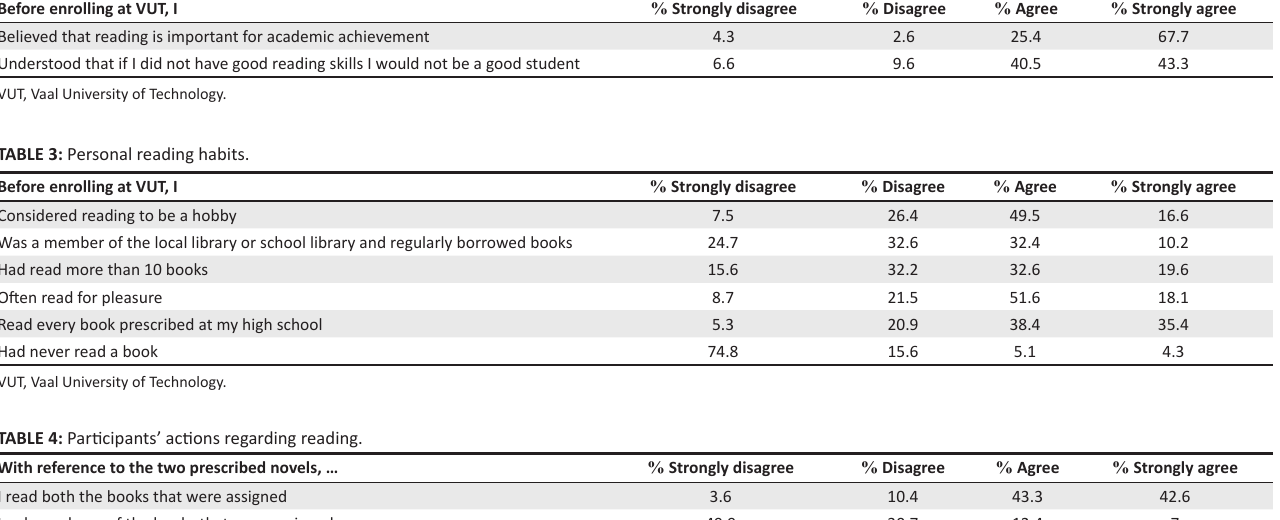
TABLE 2: Understanding the importance of reading. Before enrolling at VUT, I